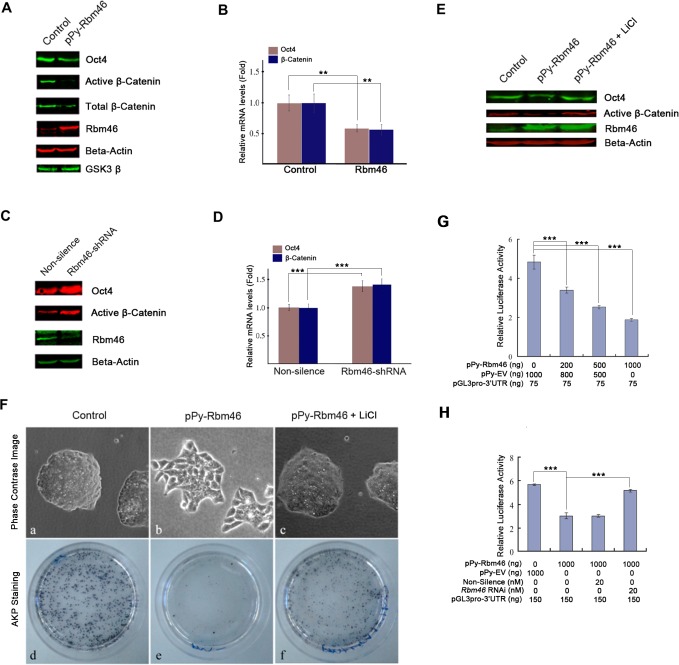
Rbm46 downregulates the mRNA level of β-Catenin.(A) pPE-E14 cells (Control) and pPy-Rbm46 cells were lysed and subjected to western blot with the indicated antibodies. (B) RT-PCR analysis of the indicated mRNA levels in pPE-E14 cells (Control) and pPy-Rbm46 cells. Experiment was performed in triplicate. Error bars showed the standard deviation. **, p<0.01; t-test. (C) Non-silence cells and Rbm46 shRNA cells were lysed and subjected to western blot with the indicated antibodies. (D) RT-PCR analysis of the indicated mRNA levels in Non-silence cells and Rbm46 shRNA cells. Experiment was performed in triplicate. Error bars showed the standard deviation. ***, p<0.001; t-test. (E) E14 cells were transfected with either empty vector or pPy-Rbm46 plasmid for 48 hours and treated with or without 10mM LiCl for 4 hours. The morphology and the AKP staining of the cell were viewed under microscope. (F) The cells treated as in (E) were lysed and subjected to western blot analysis with the indicated antibodies. (G) and (H) Luciferase reporter plasmid pGL3pro-3’UTR was transfected into Hela cells either with Rbm46 plasmid or Rbm46 plasmid plus Rbm46 RNAi. Luciferase activities were measured after 48 h. The Luciferase activity was normalized to the control reporter (SV40 Poly A) activity. Experiments were performed in triplicate. Error bars showed the standard deviation. ***, p<0.001; t-test for (G) and one-way ANOVA with Tukey’s post hoc test for (H).